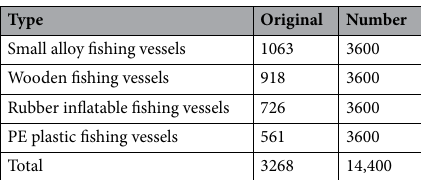
Table 2. Distribution of original sample number of MTF time series images of small fishing vessels.